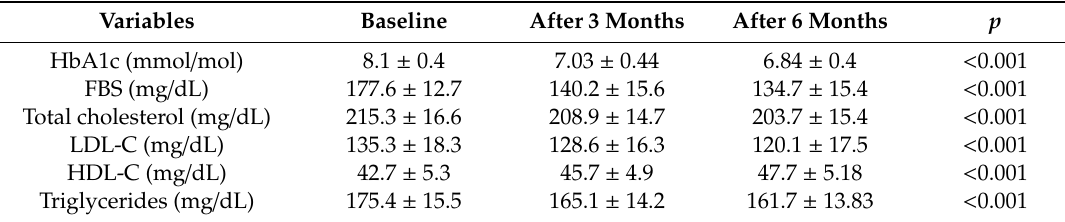
Table 2. Clinical characteristics of the study participants.